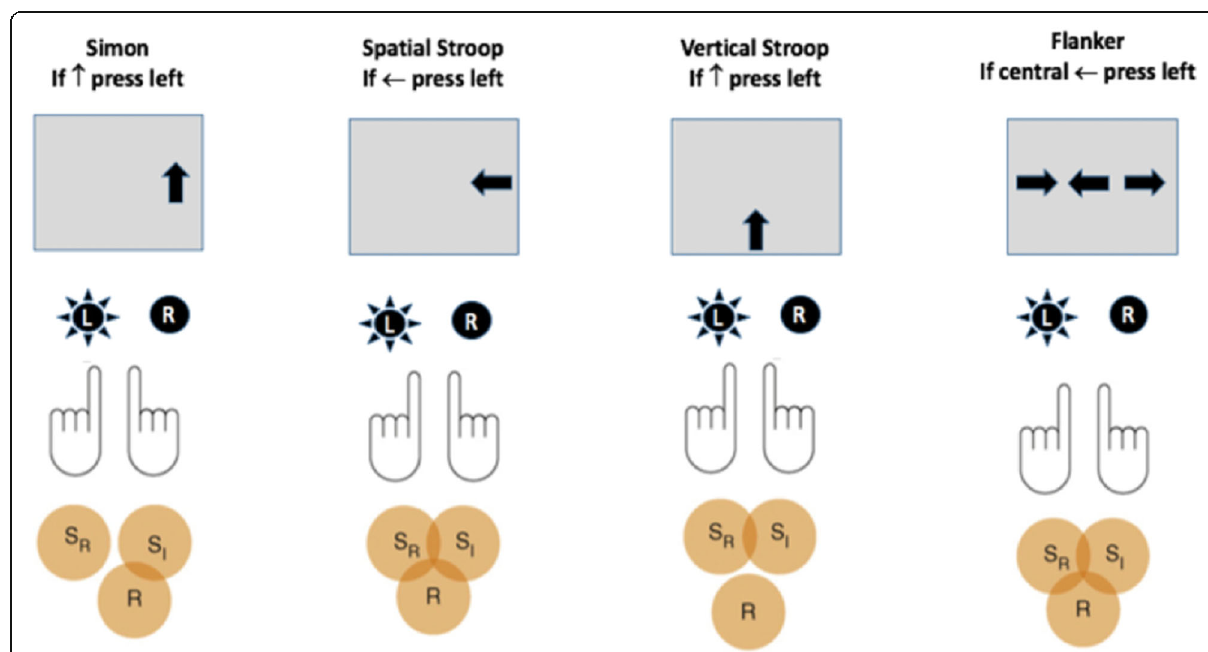
Fig. 1 The four nonverbal interference tasks used in the present study. The representational scheme is based on Fig. 1 from Egner (2008). From top to bottom for each task is the name of the task, the response rule, a screen illustrating an incongruent trial, response keys with the correct response radiated, and finally Venn diagrams showing potential conflict between the irrelevant stimulus (S I ), relevant stimulus (S R ), and response